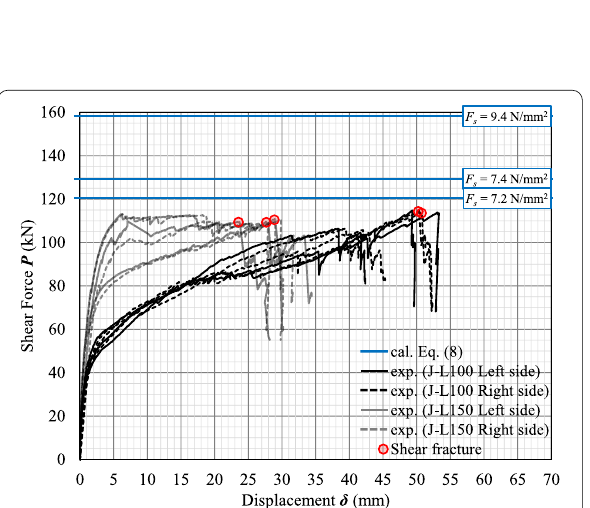
Fig. 28 Calculated shear strength vs. experimental